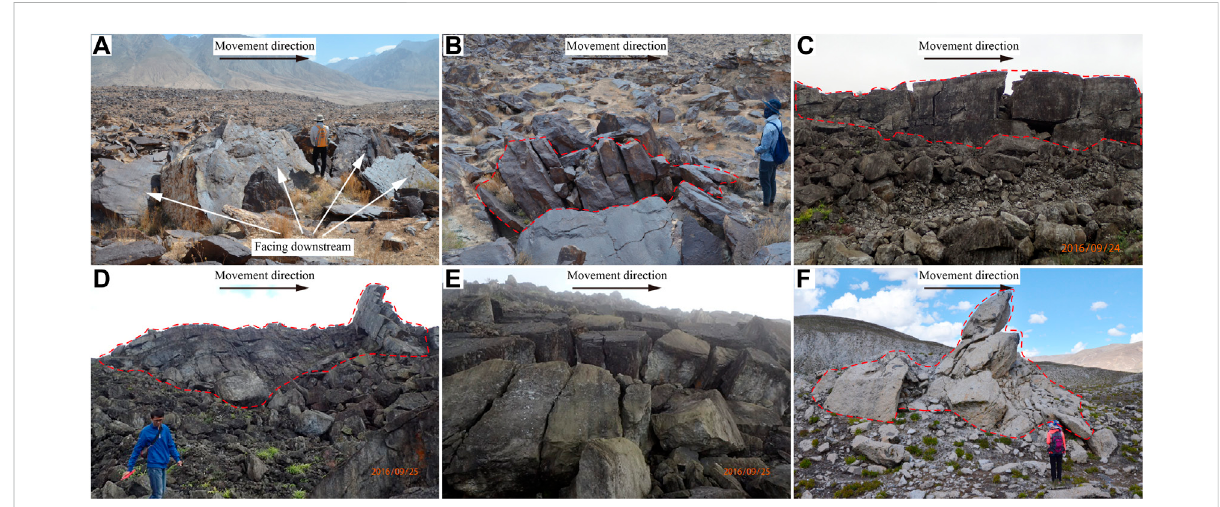
FIGURE 5 Photos showing imbricate structures (A) and jigsaw structures (B – F) deposited inthe carapacefaciesof the Tagarma (A,B) , Daguangbao (C – E) , and Nyixoi Chongco (F) rock avalanches.